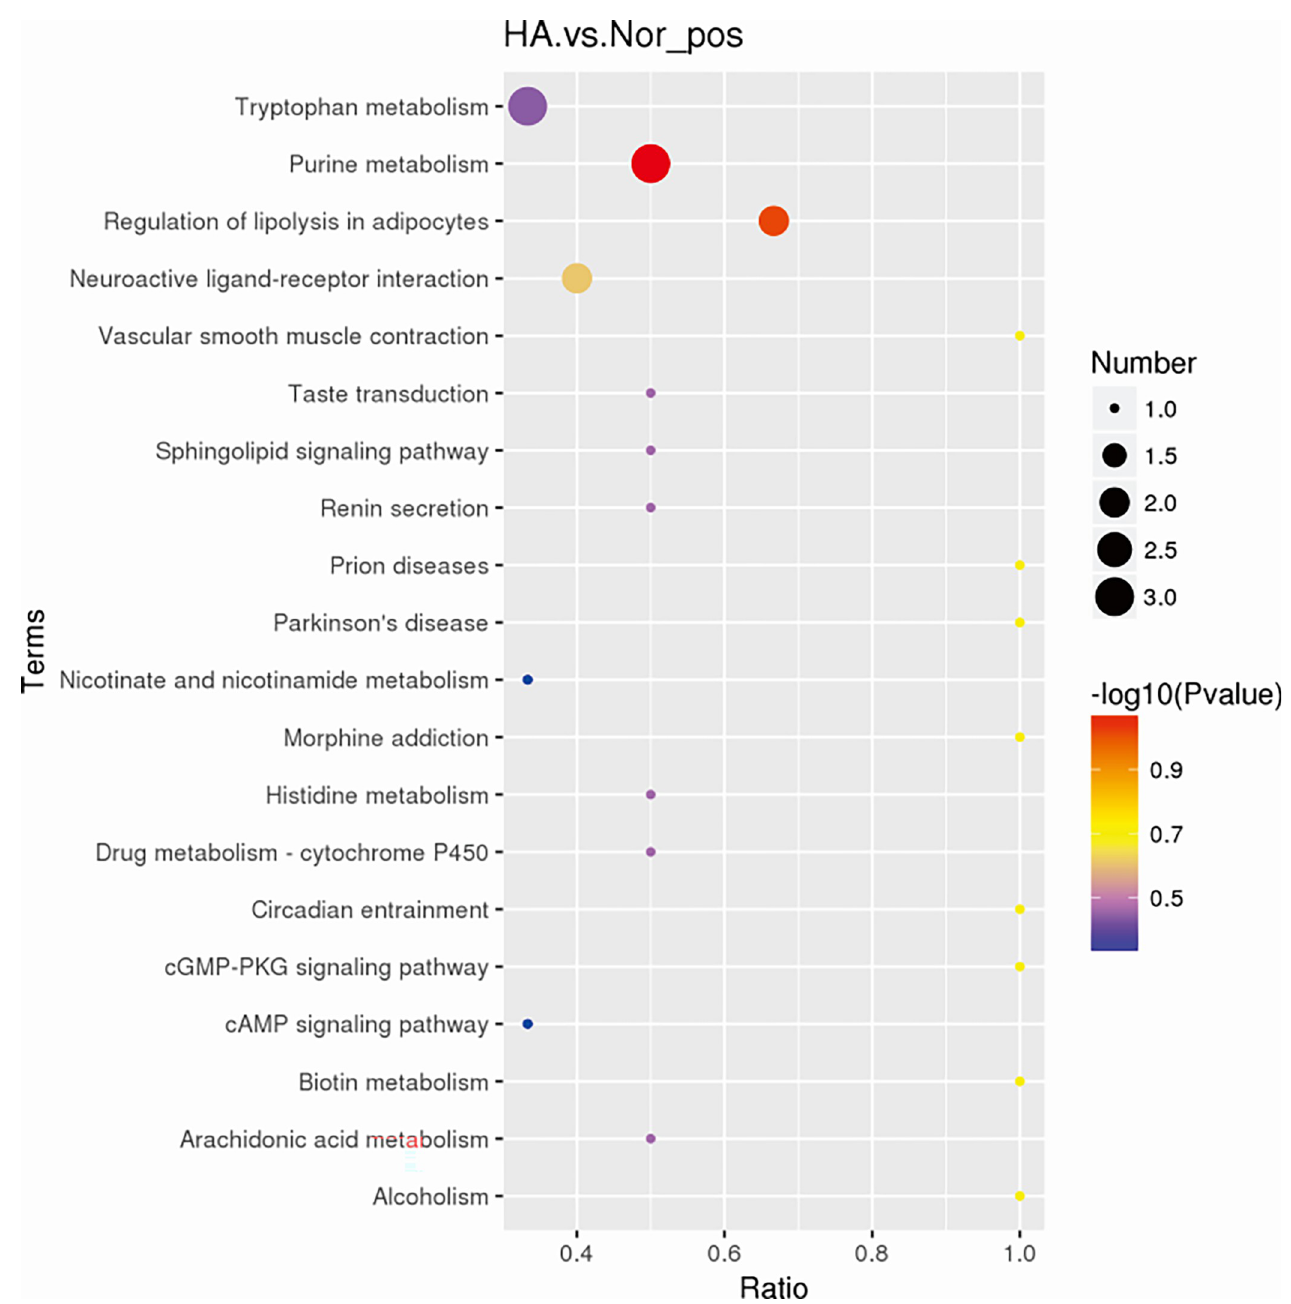
Fig 4. Enrichment analysis of significant metabolic pathways related to the HA